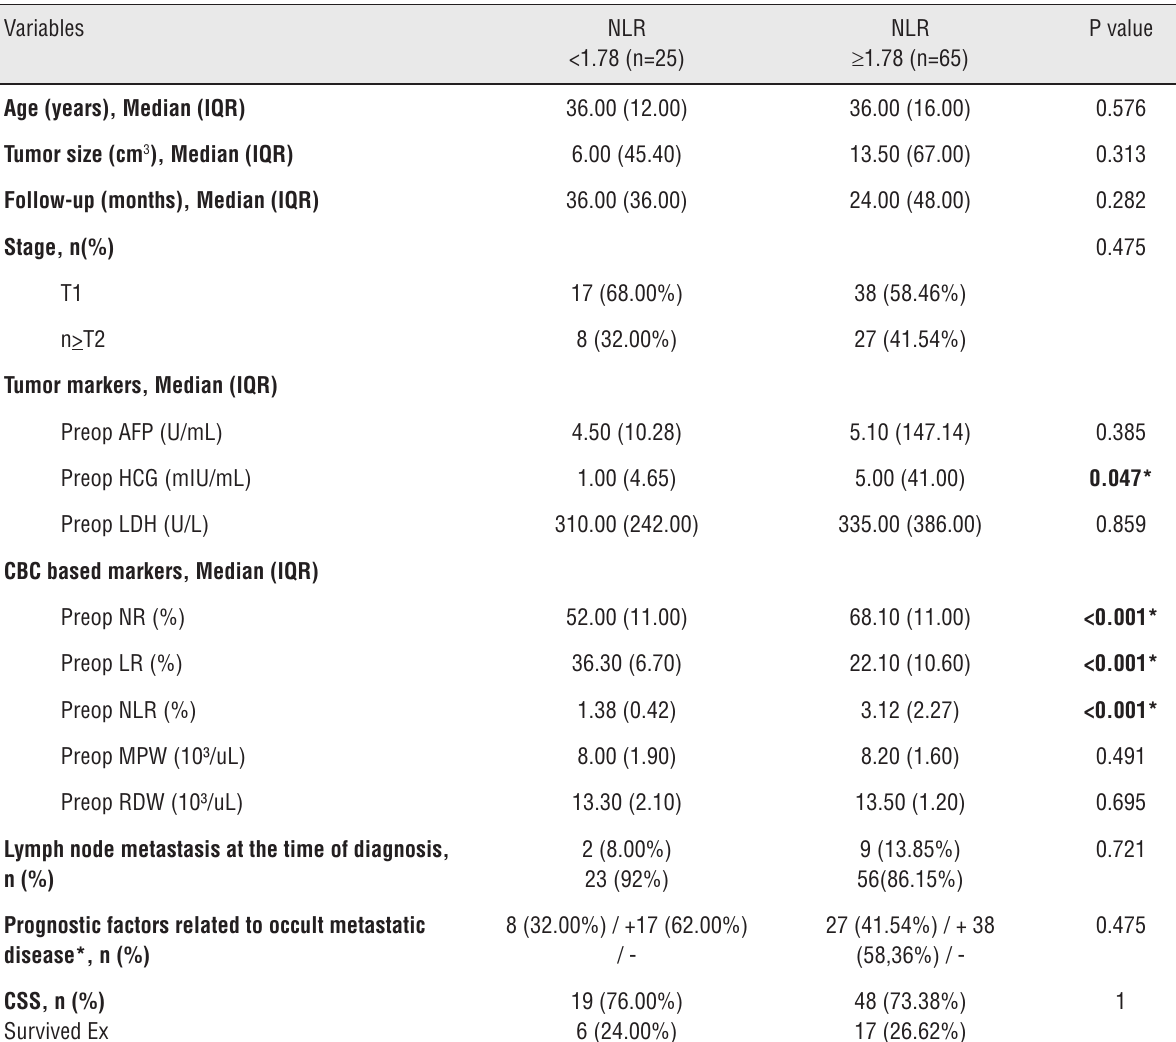
Table 4 - Distribution of descriptive properties and comparison of clinical parameters between the patients with respect to NLR of <1.78 and ≥